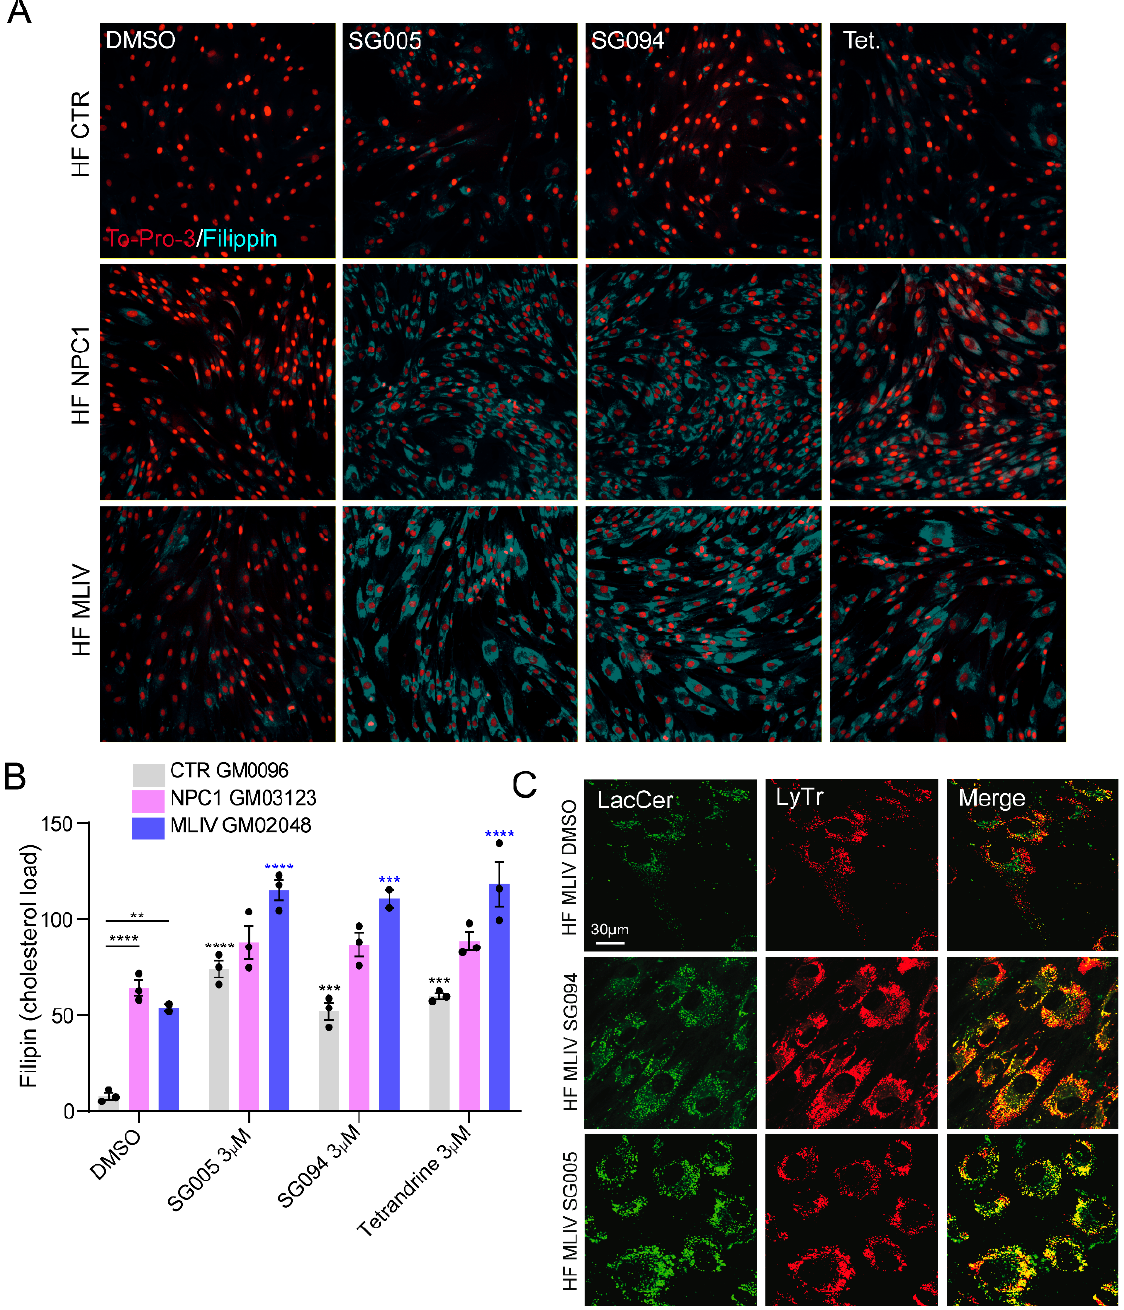
Figure 1. Effect of TPC2 inhibitors on cholesterol accumulation and lactosylceramide trafficking. ( A ) Representative confocal images showing filipin staining to visualize cholesterol accumulation and TO-PRO3 as nuclear staining. Experiments were performed in human fibroblasts: control (HF CTR), Niemann–Pick-type C1 (HF NPC1) and mucolipidosis type IV (HF MLIV) treated with either DMSO, SG005 (1 µM), SG094 (1 µM) or tetrandrine (3 µM). ( B ) Bar plot showing the filipin intensity per cell (expressed as cholesterol load). Shown are mean values ± SEM. n > 3 biological replicates for each tested condition. ** p -value < 0.01; *** p -value < 0.001; **** p -value < 0.0001. Two-way ANOVA, post hoc Tukey’s multiple comparisons test. ( C ) Representative confocal images of LacCer (green) and LysoTracker (LyTr; red) in HF MLIV treated with DMSO, SG005 (1 µM) or SG094 (1 µM).